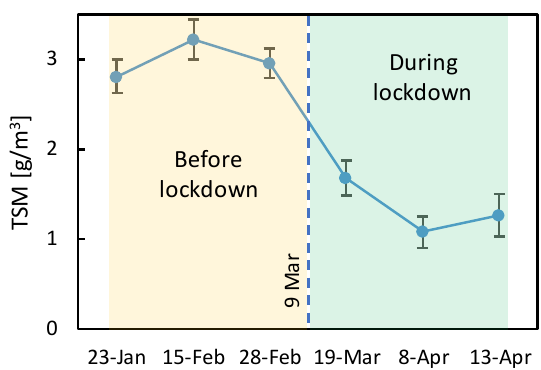
Figure 3. Temporal variations of the average TSM estimates and associated standard deviations capturing the impact of the COVID-19 lockdown on the turbidity of the water in the Venice lagoon.